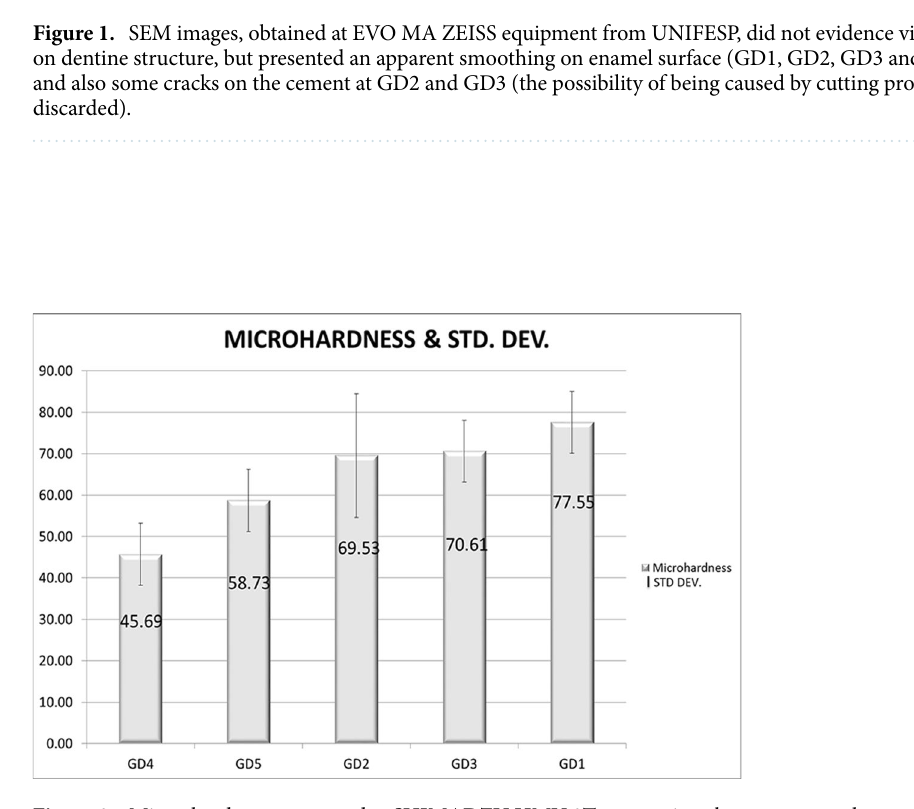
Figure 2. Micro-hardness, measured at SHIMADZU HMV 2T, comparison between control group and sterilization methods, bars indicate the average hardness and the lines represent the standard deviation. Anova statistical analysis (Anova and graphics produced at excel 2013) indicates a significant association between the sterilization method and the micro-hardness, H value is highly significant 52.5432 ( p =